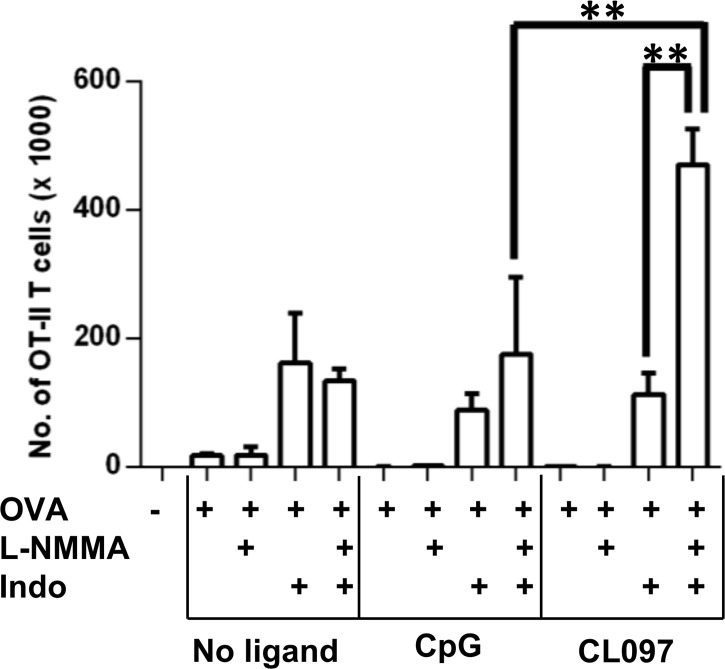
Simultaneous inhibition of COX-1/COX-2 and iNOS synergistically enhances OT-II CD4+ T cell proliferation stimulated with OVA protein plus CL097 in 2-week culture.5 x 103 OT-II CD4+ T cells were mixed with 1 x 105 congenic DCs, and incubated with a combination of OVA protein, CpG, CL097, L-NMMA (40 μM), and Indo (10 μM) for 2 weeks to measure long-term CD4+ T cell expansion in vitro. At the end of the culture period, 4 x 105 splenocytes from WT C57BL/6 mice (CD45.2) were spiked into the cultures to calculate the number of OT-II CD4+ T cells (CD45.1). Cells were stained with anti-CD45.1 and anti-CD4 antibody to measure the expansion of OT-II CD4+ T cells. 7-AAD was used to exclude dead cells in the analysis. Shown are mean numbers of OT-II CD4+ T cells of triplicate wells ± SD. Statistical differences were analyzed by one-way ANOVA. Data are expressed as mean ± SD of triplicate wells. Data shown are representative of three independent experiments. **p<0.001. iNOS: inducible nitric oxide synthase; COX: cyclooxygenase.